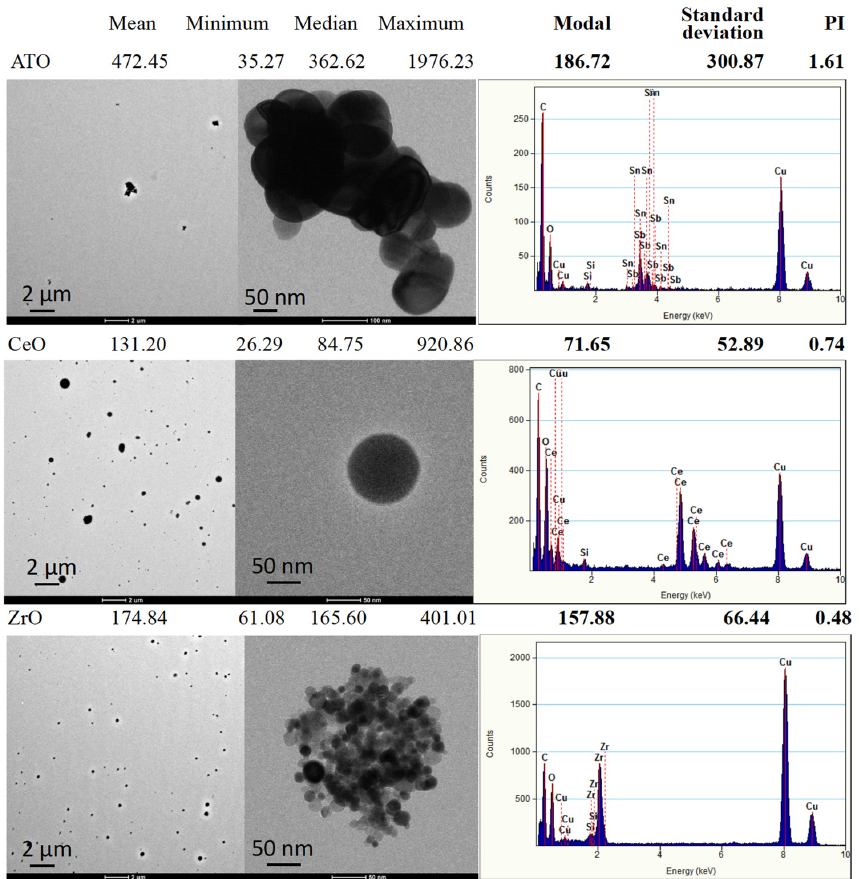
Figure 3. Representative transmission electron microscopy (TEM) images of the generated aerosols (EDS spectra) with respective size distribution values. The size distribution of aerosol generated particles was determined from TEM images by using the ImageJ software.